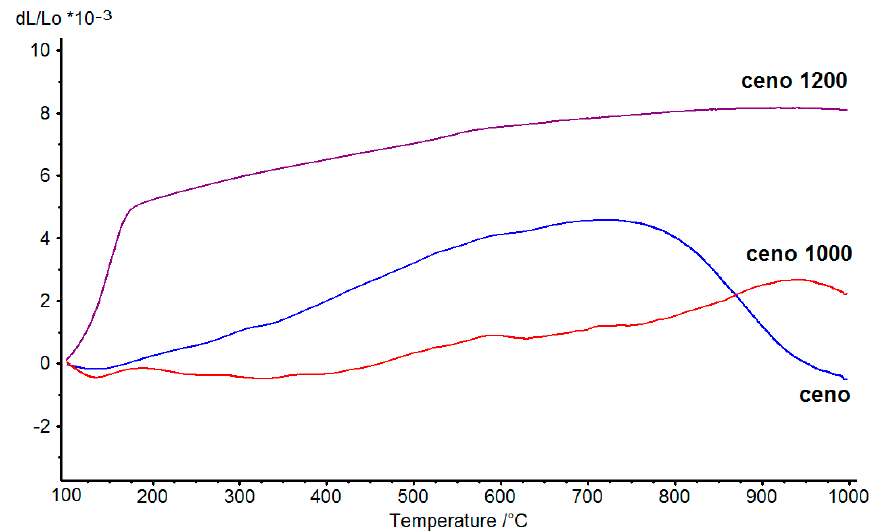
Figure 8. Expansion curves of cenospheres and heat-treated cenospheres at temperatures from 100 °C to 1000 °C.